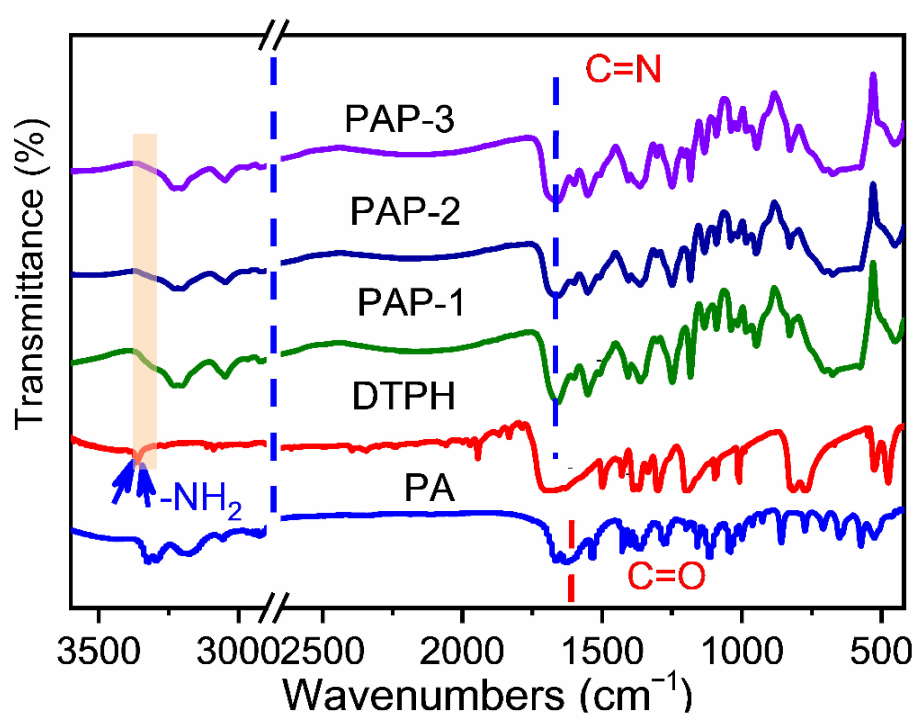
Figure 1. FT-IR spectra of PA, DTPH, and the resultant dynamic covalent materials PAP-X (X = 1, 2, 3). Solid-state 13 C-NMR characterization was used to further verify imine assembly. As shown in Figure 2, the characteristic signal at 163 ppm corresponded to the chemical shift of the C=N bond in PAP − 1 [41,42]. In addition, the peak of the benzene ring derived from PA at 135 ppm and the peaks of C–C derived from DTPH at 35 ppm can observed. The phenomena above proved the successful assembly of PA and DTPH through imine bonding.